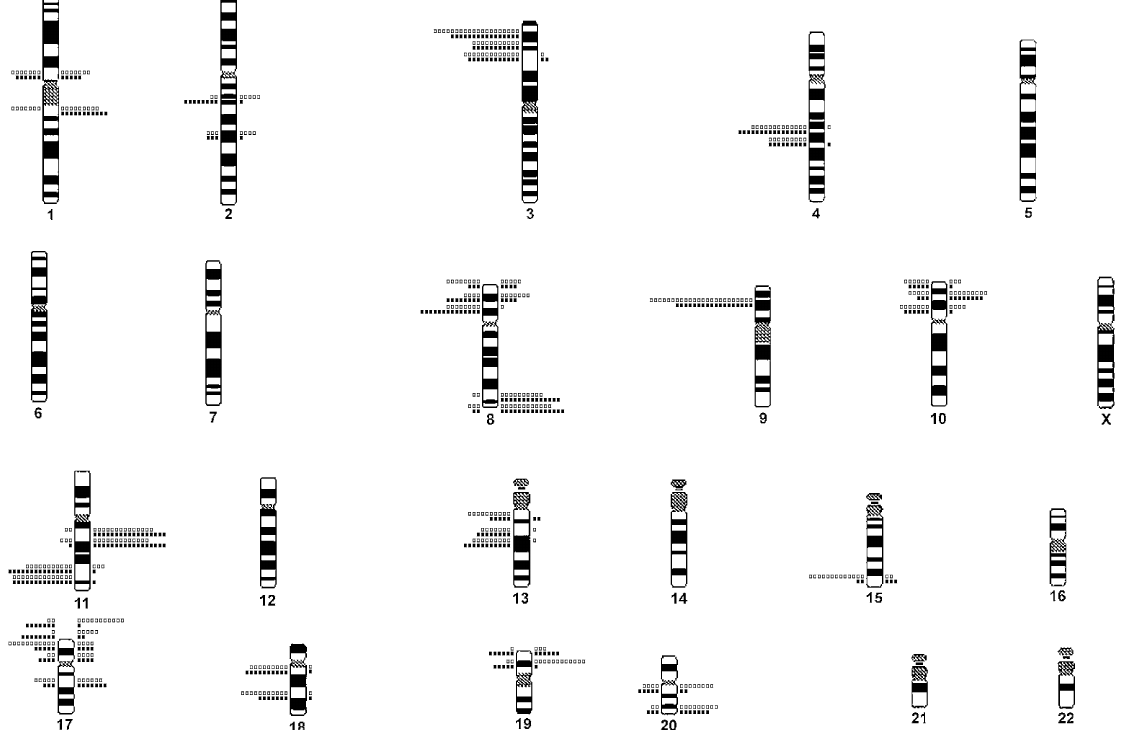
Fig. 1. Genetic alterations in 56 larynx and pharynx primary carcinomas detected by MLPA. Squares to the right of each chromosome represent gains and squares to the left represent losses. White squares represent lymph node negative tumors and black squares represent lymph node positive